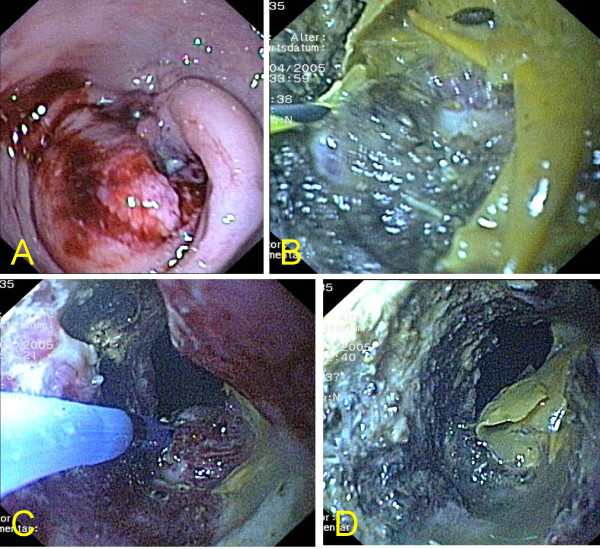
Colonoscopic picture of patient 1 at first presentation showing stenosis of the sigmoid which could not be passed by the colonoscope (A). Endoscopic snare debulking of the distal part of the tumor allowed to push the wire beyond the stenosis (B). After passing the tumor APC ablation of the proximal part of the tumor could be performed opening a channel (C). View of the stenosis after complete debulking. Note the channel with stool covering the luminal surface (D).